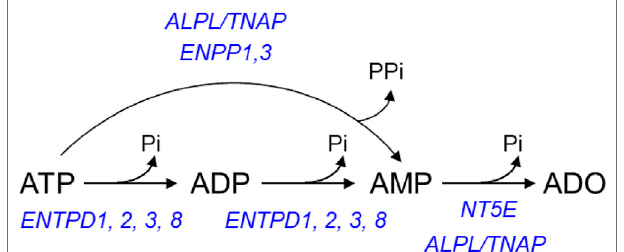
FIGURE 1 | Principal pathways of extracellular ATP hydrolysis. ATP is hydrolyzed to ADP and then ADP is hydrolyzed to AMP by ENTPD1, 2, 3,